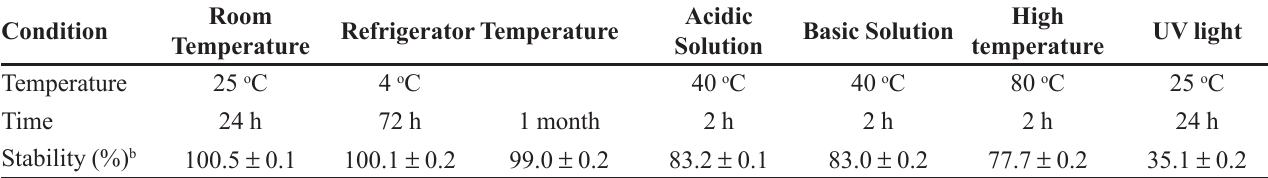
TABLE III - Recuperation (%) of RIV a after the exposition on various conditions of temperature, pH and UV light